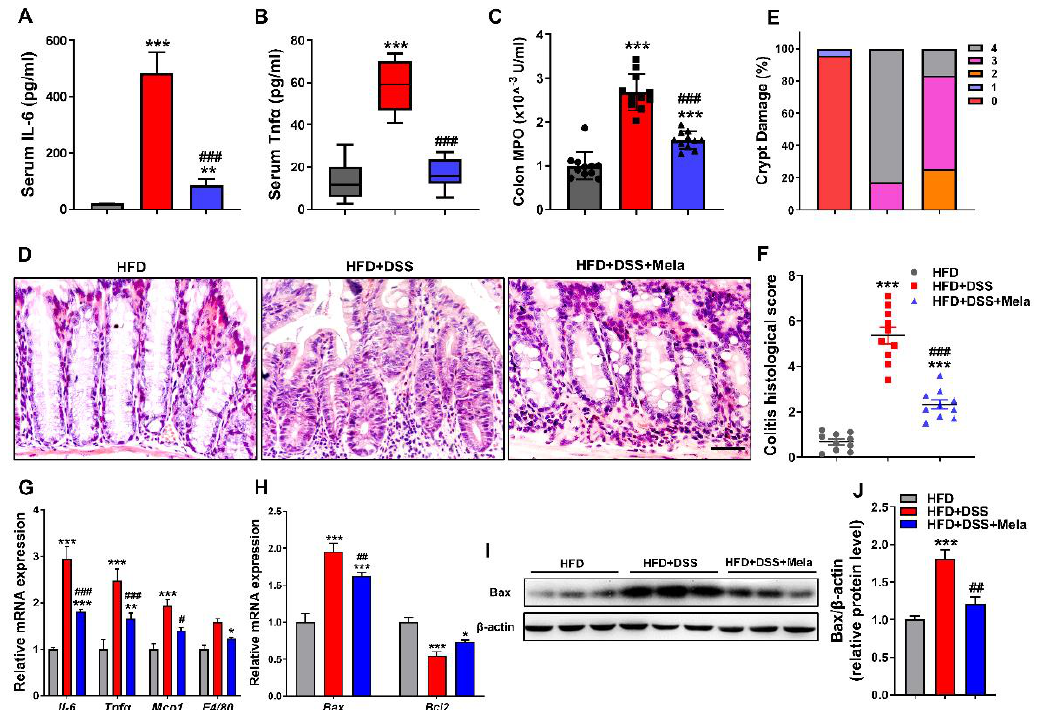
Figure 3. Melatonin attenuates DSS-induced inflammation and apoptosis in obese mice. (A and B) ELISAs of the production of serum IL-6 ( A ) and Tnf α ( B ). ( C ) MPO activity in mucosal lysates of mice. ( D – F ) Representative H&E staining ( D ), colitis histological score ( E ), and crypt damage ( F ) in colons. Scale bar = 50 µ m. ( G , H ) Real-time RT-PCR quantitation of colon proinflammatory cytokines ( G ) and apoptosis-associated genes ( H ). ( I , J ) Immunoblot analysis of Bax proteins in colon tissues ( I ) and quantification ( J ) in the three groups of mice. The data are expressed as the mean ± SEM. n = 10. * p < 0.05, ** p < 0.01, *** p < 0.001 compared with HFD; # p < 0.05, ## p < 0.01, ### p < 0.001 versus HFD + DSS.